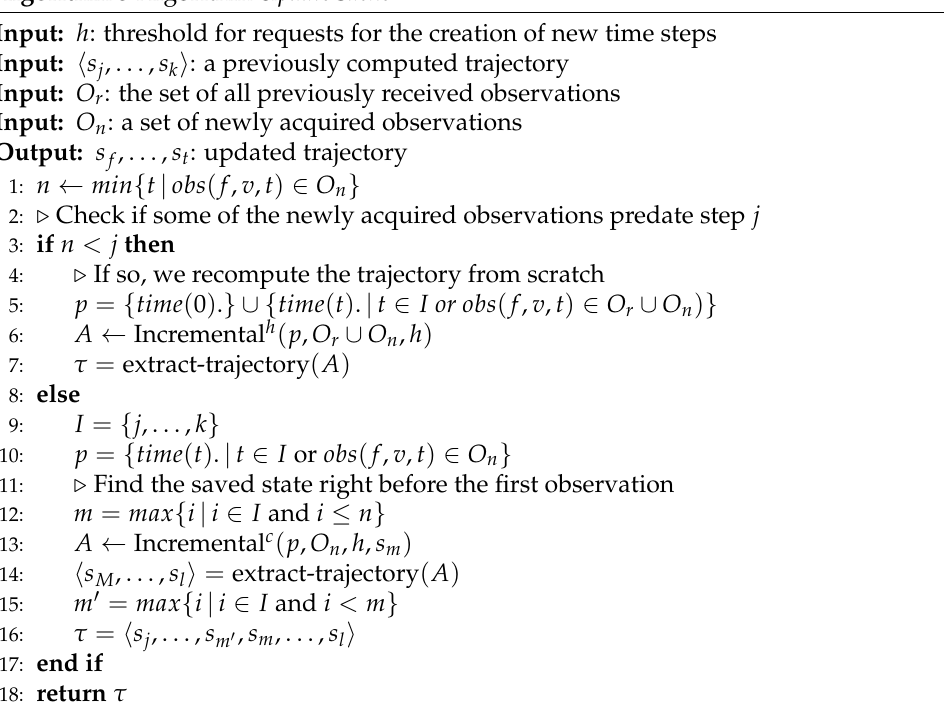
Algorithm 5 Algorithm